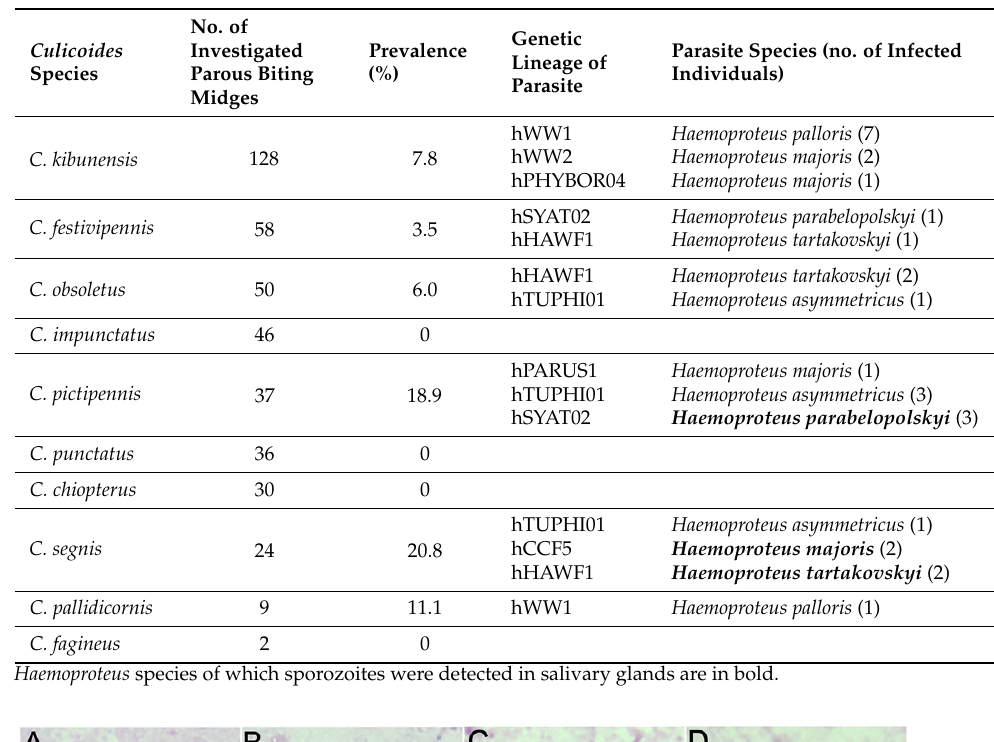
Table 1. Species list of collected and studied Culicoides females and detected haemoproteids.